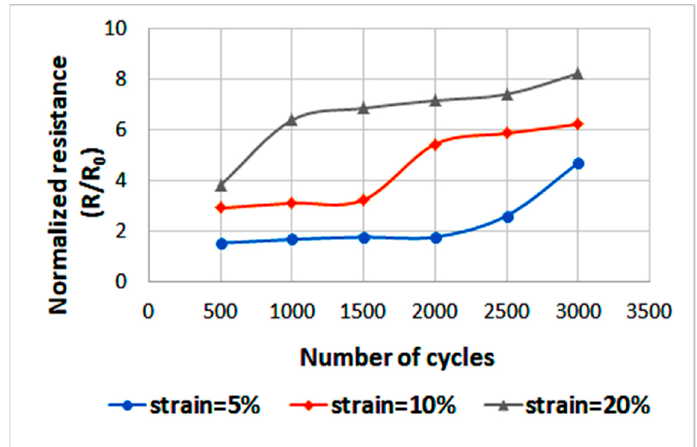
Figure 16. Normalized resistance (R/R 0 ) for the optimal horseshoe pattern as it is cycled up to 3000 cycles at strains of 5, 10, and 20%.